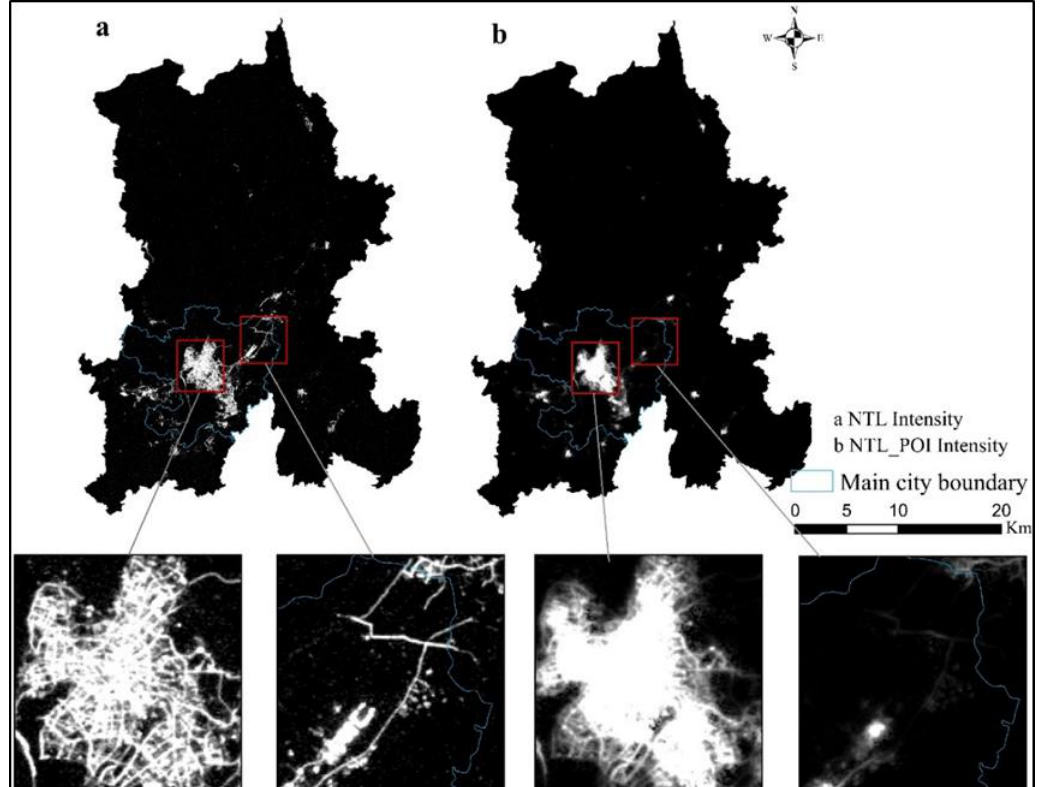
Figure 12. Comparison of NTL and NTL_POI data.